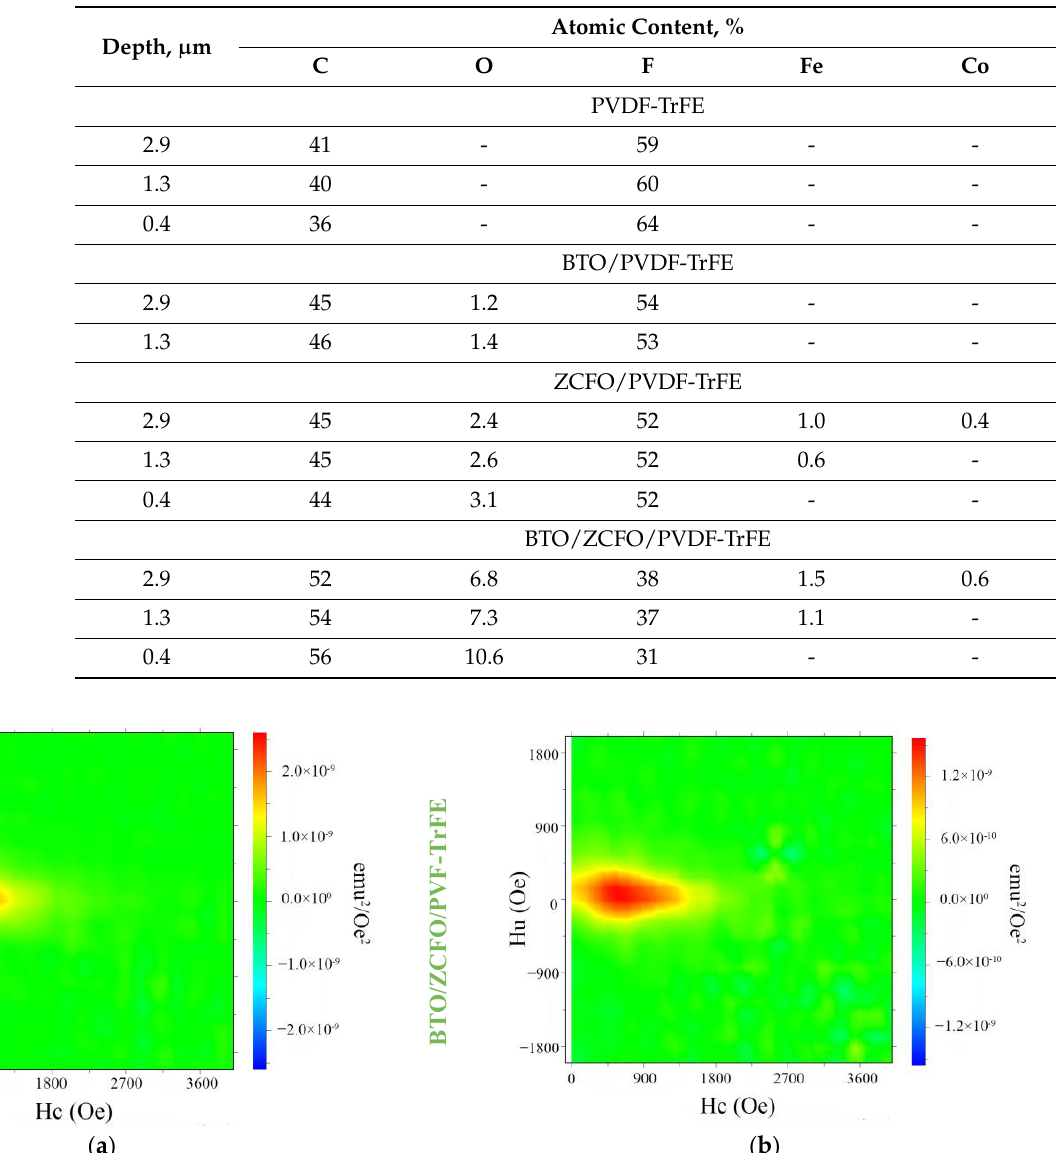
Table 1. Elemental atomic content (C, O, F, Fe and Co) at different depths (2.9, 1.3 and 0.4 µ m) from acquired EDX signal. The evaluation errors are: 1–2% for C, F and O, and 0.1–0.3% for all other elements.